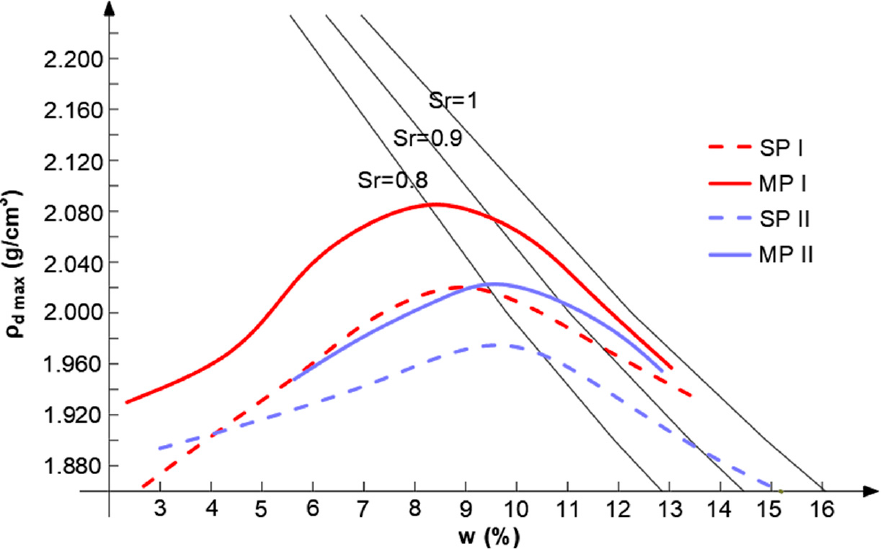
Figure 2. Compaction curves obtained using the standard Proctor (SP) and modified Proctor (MP) methods for research samples I and II.